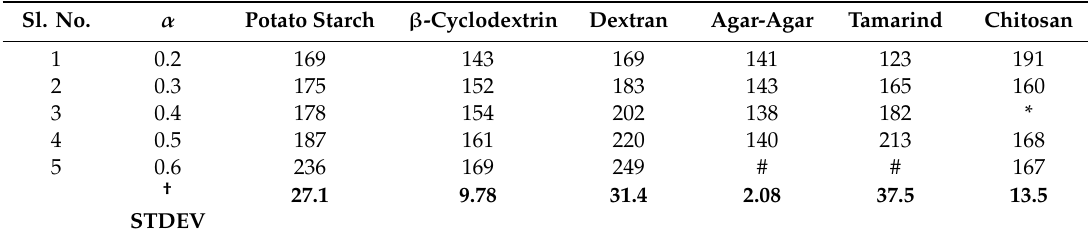
Table 2. Activation energies (kJ · mol − 1 ) of each substrate for di ff erent α values. Sl. No.